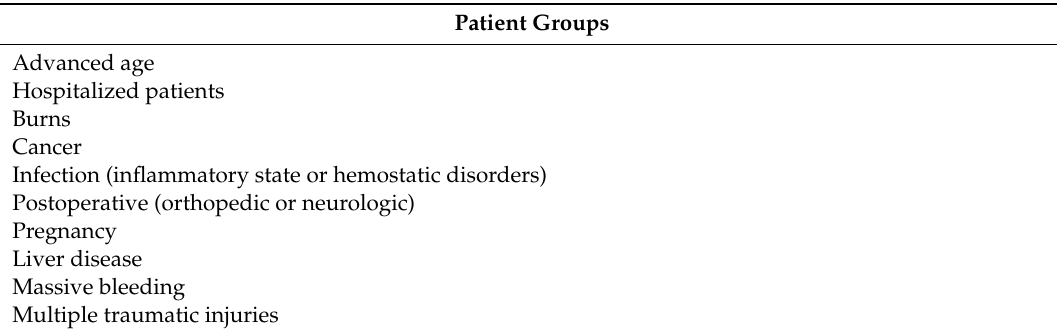
Table 1. Conditions for which the D-dimer may not be